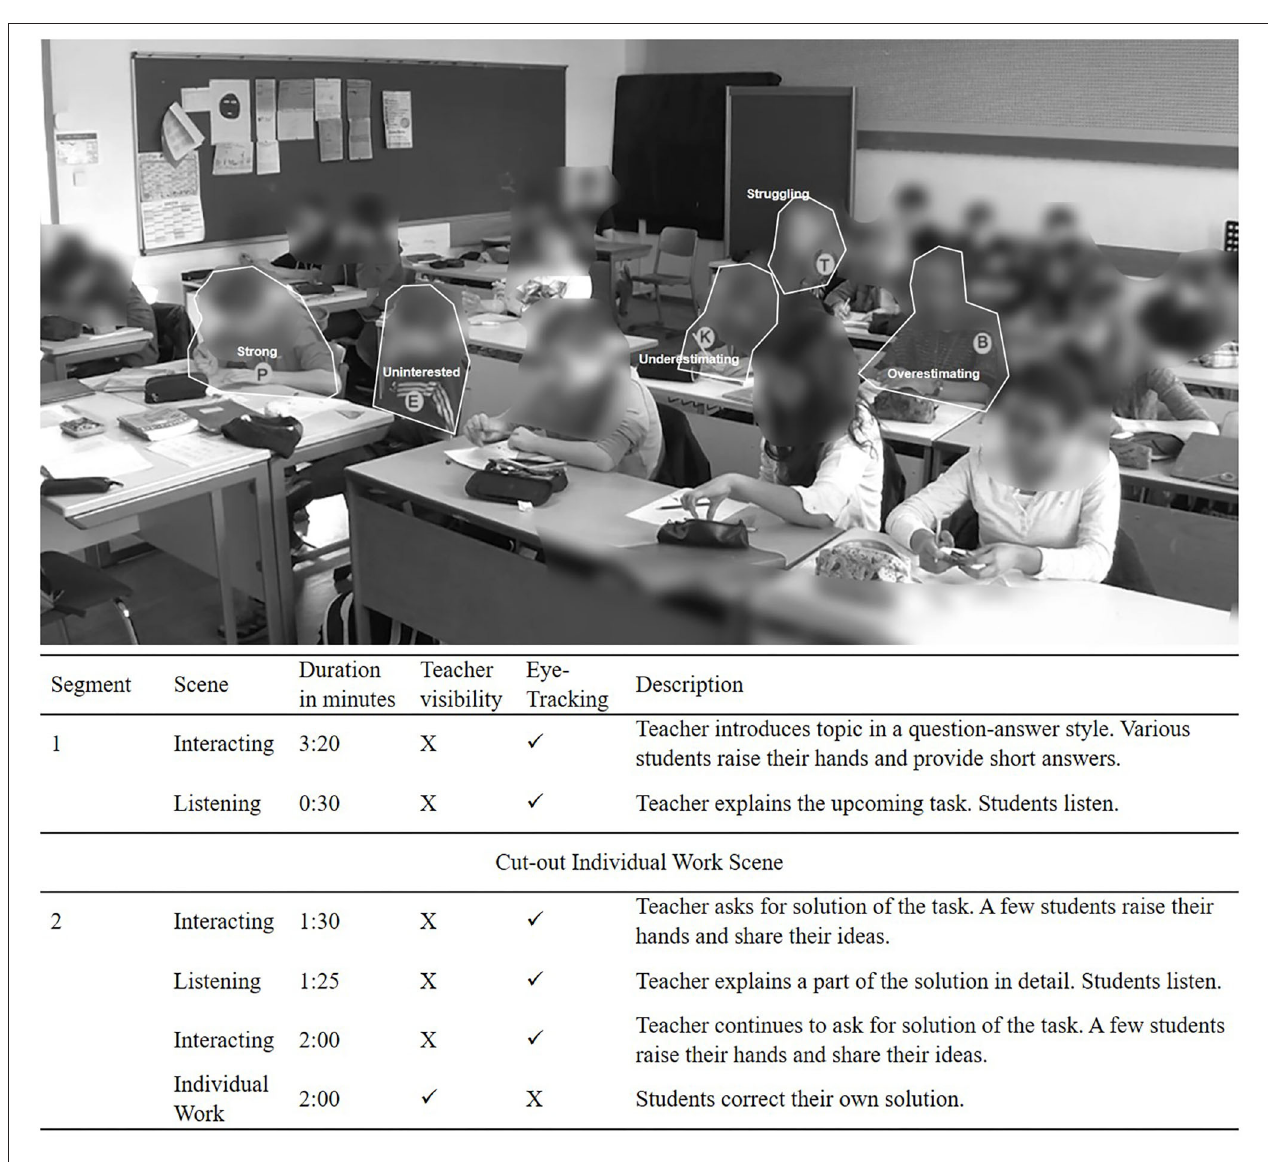
FIGURE 1 | Video stimulus used for eye-tracking analysis. This is an exemplary screenshot of the classroom and areas of interest (AOI) used. AOIs are only marked for the purposes of illustration in this paper, and were not visible to participants. Faces are also blurred for presentation in the publication to ensure the protection of data privacy; faces were visible to participants during the study and when drawing the AOIs. Students were marked with letters that did not refer to any underlying profile: B, E, K, P, and T. This figure was previously published as “Video stimulus for eye movement analysis” by Seidel et al. (2020) and is licensed under CC BY 4.0. The original figure was changed by adding the Table in the lower